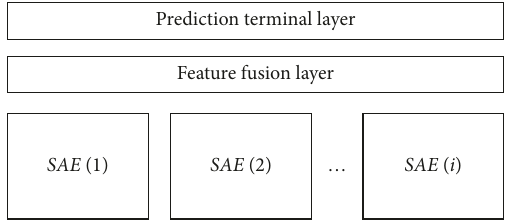
Figure 5: Cascade deep learning model for power generation prediction of offshore wind